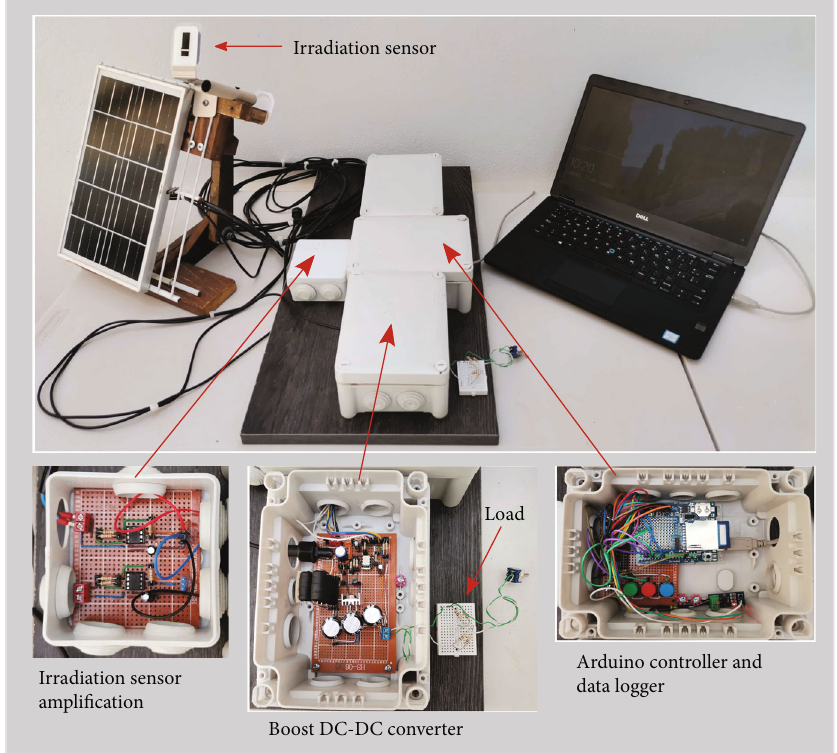
Figure 7: Experimental setup for radiation measurements and implementation of the control strategy.